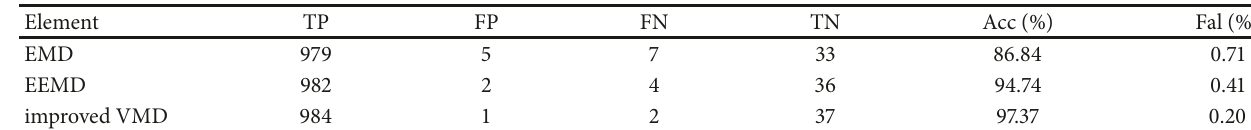
Table 2: Detection rate and error rate.